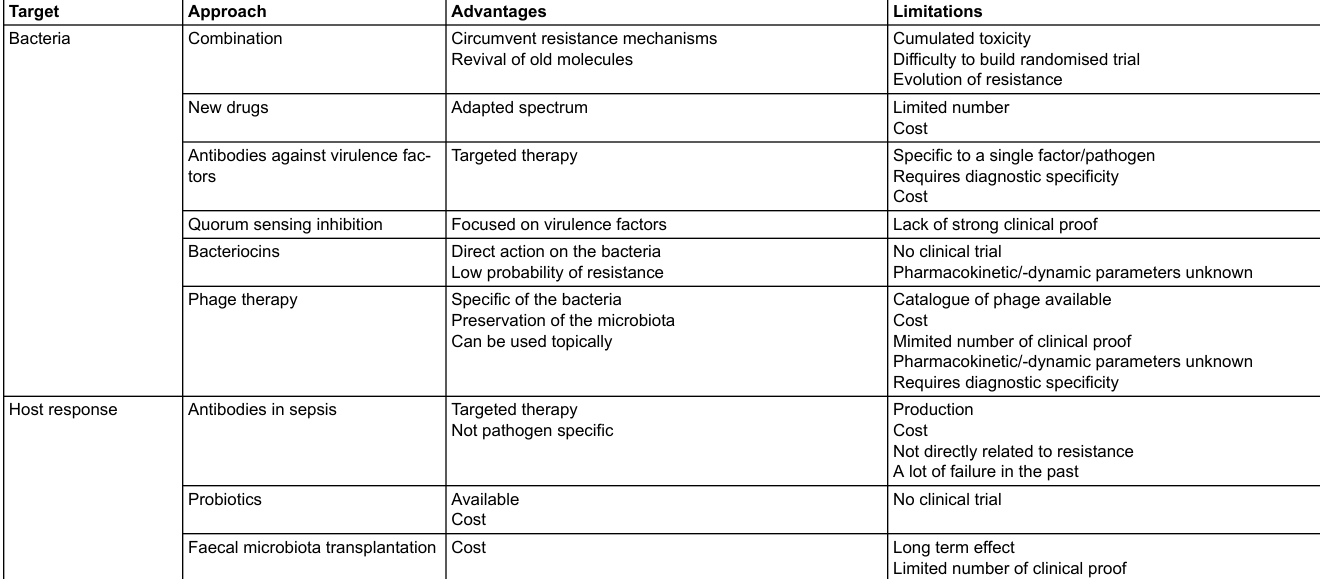
Table 1: Advantages and limitations of non-antibiotic